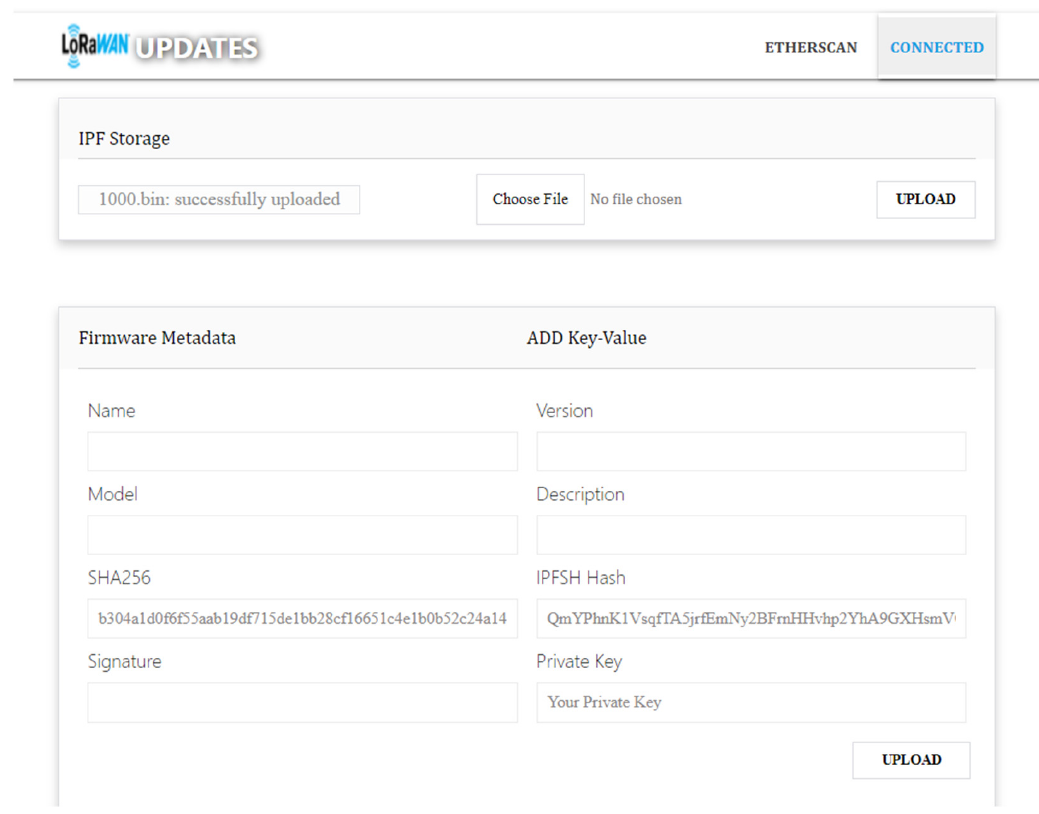
Figure 12. Manufacturer–User Interface. Algorithm 1: Upload a new firmware manifest